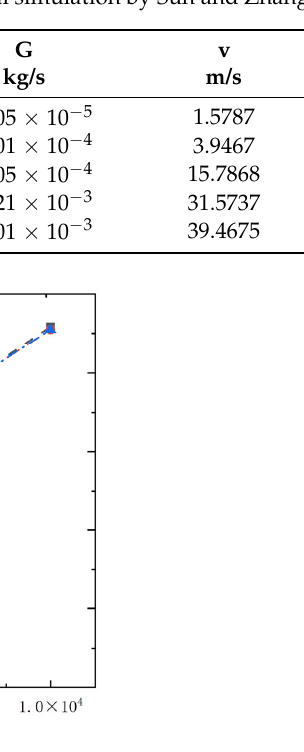
Table 5. Working conditions of the numerical simulation by Sun and Zhang [20].